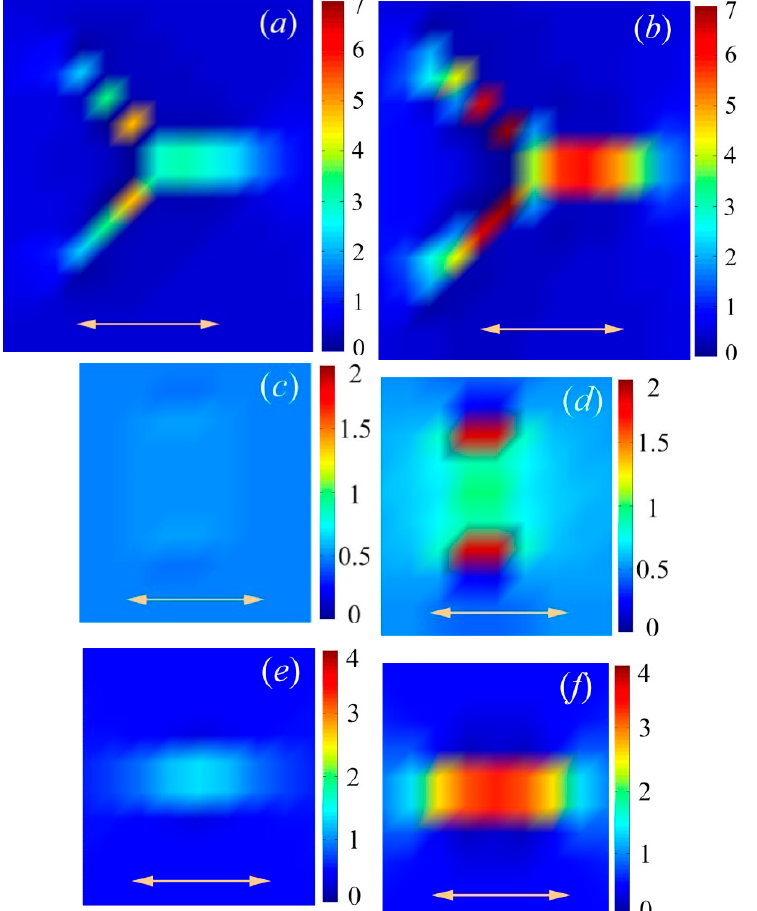
Figure 6. Normal stress profiles through the center of the particles with weak ( a , c , e ) and strong ( b , d , f ) NPI. Yellow double arrows indicate the stretching direction. Particles include tetrapods ( a , b ), vertically aligned rods ( c , d ) and horizontally aligned rods ( e , f ). The color bars indicate the value of stress for each bead.